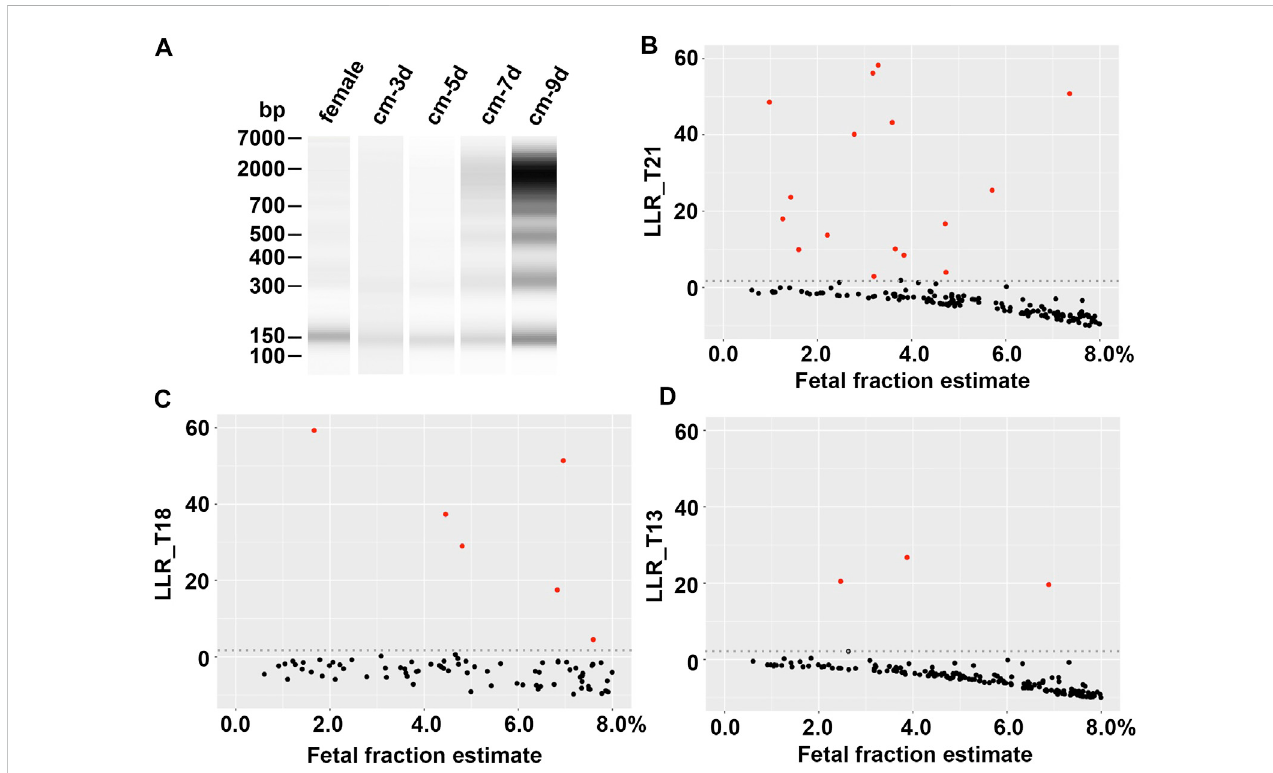
FIGURE 1 Evaluation of synthetic plasmas. (A) cfDNA size distribution. From left to right, cfDNA from a normal female plasma (female), culture media from a chorionic villus specimen with a 45,X karyotype collected atthe day 3, 5, 7, and 9 of the culture, respectively (cm-3d, cm-5d, cm-7d, and cm-9d). (B) , (C) , and (D) Log likelihood ratios (LLRs) of synthetic plasmas (fetal fraction estimate ≤ 8%) with trisomy 21, trisomy 18, and trisomy 13, respectively. Red dot, synthetic positive plasma; black dot, negative maternal plasma; gray dotted line, LLR